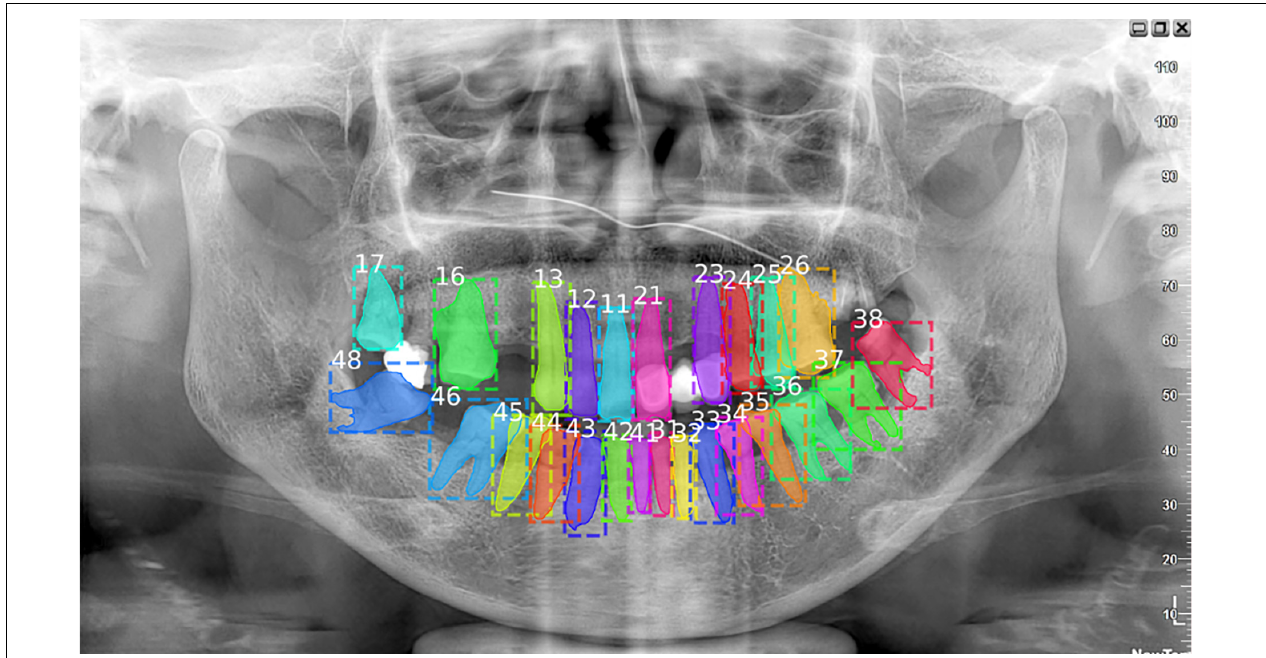
FIGURE 6 | This case missed the filled tooth between number 17 and 16. Actually, the missing tooth should be number 17 and the tooth which is wrongly numbered as 17 should be 18. Considering about the filled teeth could enhance the performance of teeth numbering and segmentation tasks.